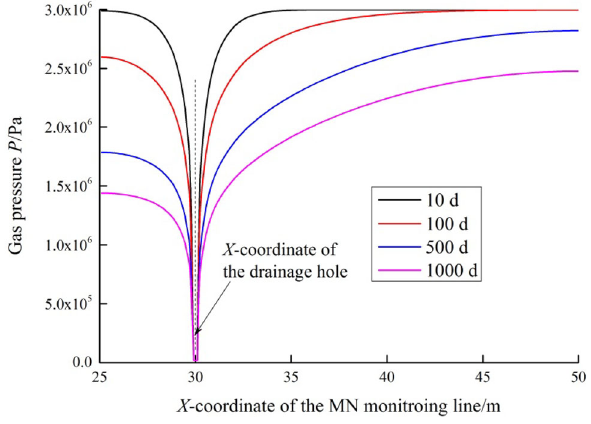
Fig. 3 Gas pressure distribution on the monitoring line MN with heat injection temperature Figure 6 showed the influence of different heat injection temperatures T on the temperature distribution in the coal z seam. The higher the heat injection temperature, the faster was the heat transfer. When heat was injected at 120 (cid:3) C and 150 (cid:3) C for 100 d, the temperatures at the extraction borehole were 44.4 (cid:3) C and 49.2 (cid:3) C, respectively. When heat was injected for 500 d, the temperatures at the extraction boreholes reached 70.1 (cid:3) C and 83.5 (cid:3) C, respectively.